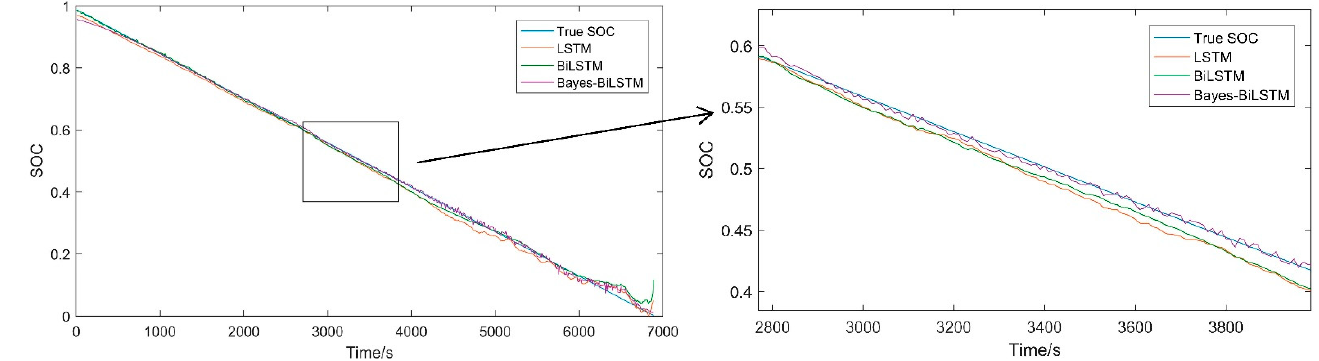
Energies 2022 , 15 , x FOR PEER REVIEW